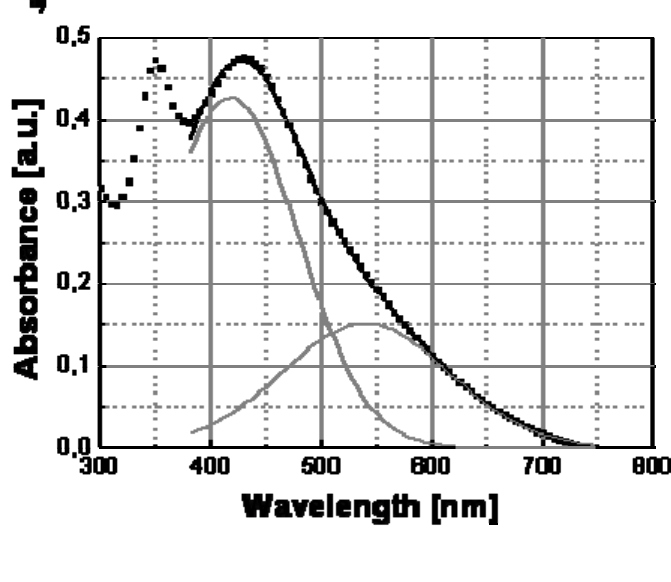
Figure 8. Deconvolution of the surface plasmon absorptionof Ag/PS nanocomposite obtained by thermal decomposition of silver dodecyl-thiolate at temperature below and above the transition temperature of 120 °C: (a) 30 °C; (b) 160 °C. The red curves are obtained in each case by adding the contributions of the Gaussian curves (grey lines) and smoothly interpolate the experimental data (square